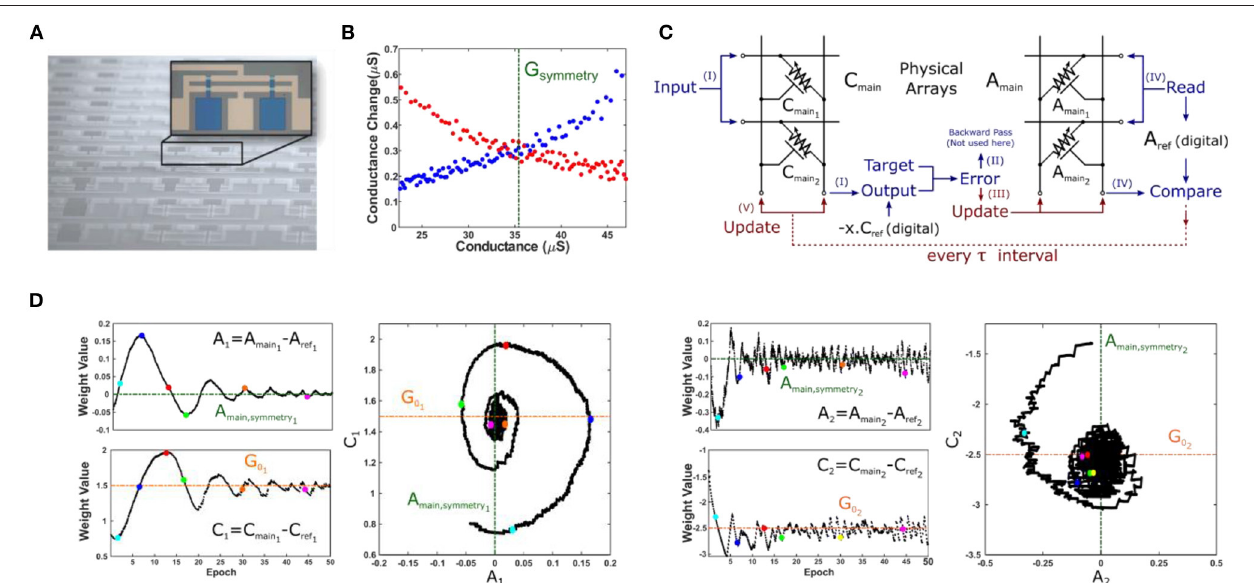
FIGURE 3 | Experimental demonstration of SHD training algorithm. (A) Optical micrograph of metal-oxide based electrochemical devices (Sebastian et al., 2017). Note that the image shows an integrated array whereas experiments were conducted with individual devices connected externally. (B) Conductance modulation characteristics obtained for one of the devices, showing “crossed-swords” behavior with a well-defined symmetry point. (C) Schematic for array configuration used in 2-parameter optimization with SHD algorithm. All steps are shown using the same notation used in Figure 2 except for the backward pass (Step II ) which is not required for a single layer network. For training, sum of squared errors is used to calculate the scalar error and vector δ , C main is updated once every 10 samples (i.e., τ = 10) whereas [ 1,0 ] and [0,1] were used in Step IV (as u vectors). The reference arrays containing symmetry point information are stored in digital (as they remain unchanged throughout the training) for simplicity. (D) Evolution of device conductances for the first ( A 1 , C 1 ) and the second ( A 2 , C 2 ) parameters. Plotting the values of A vs. C produces the distinctive spiraling image, as expected from the theoretical analysis.